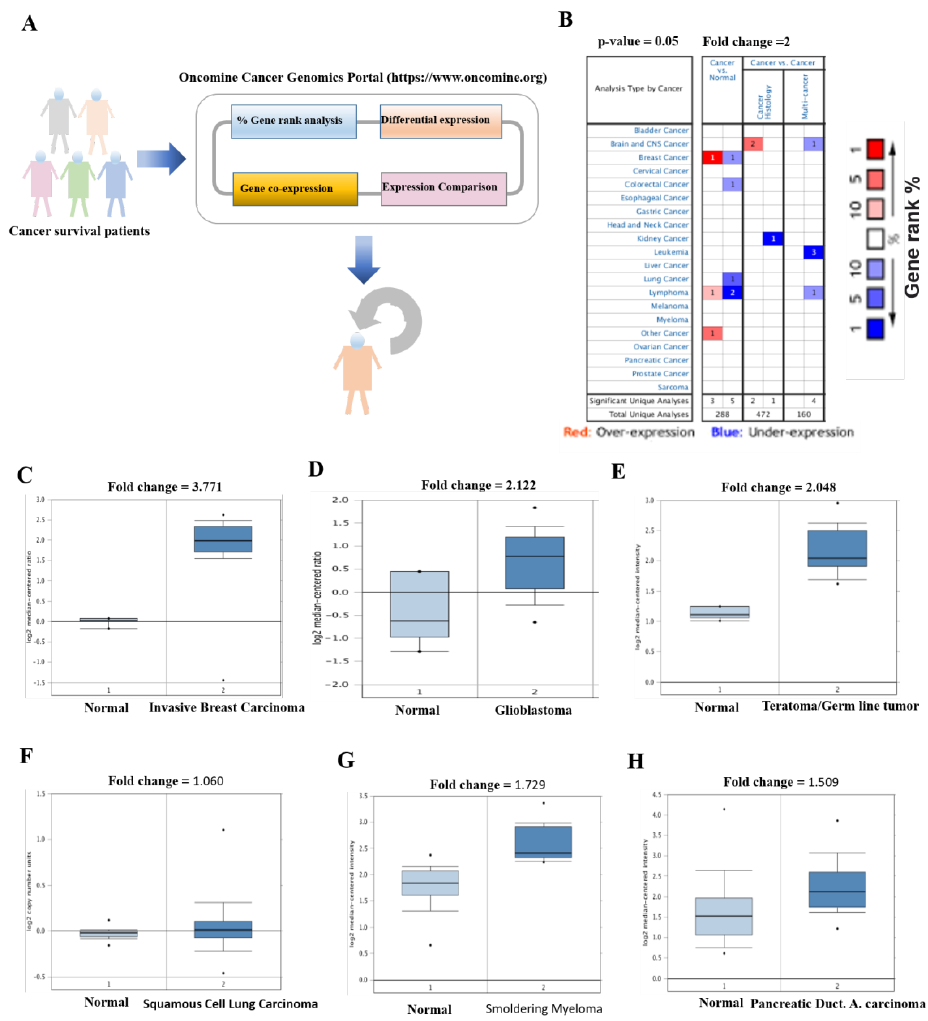
Figure 2. Elevated levels of SERTAD1 associated with cancers. ( A ) Schematic presentation of